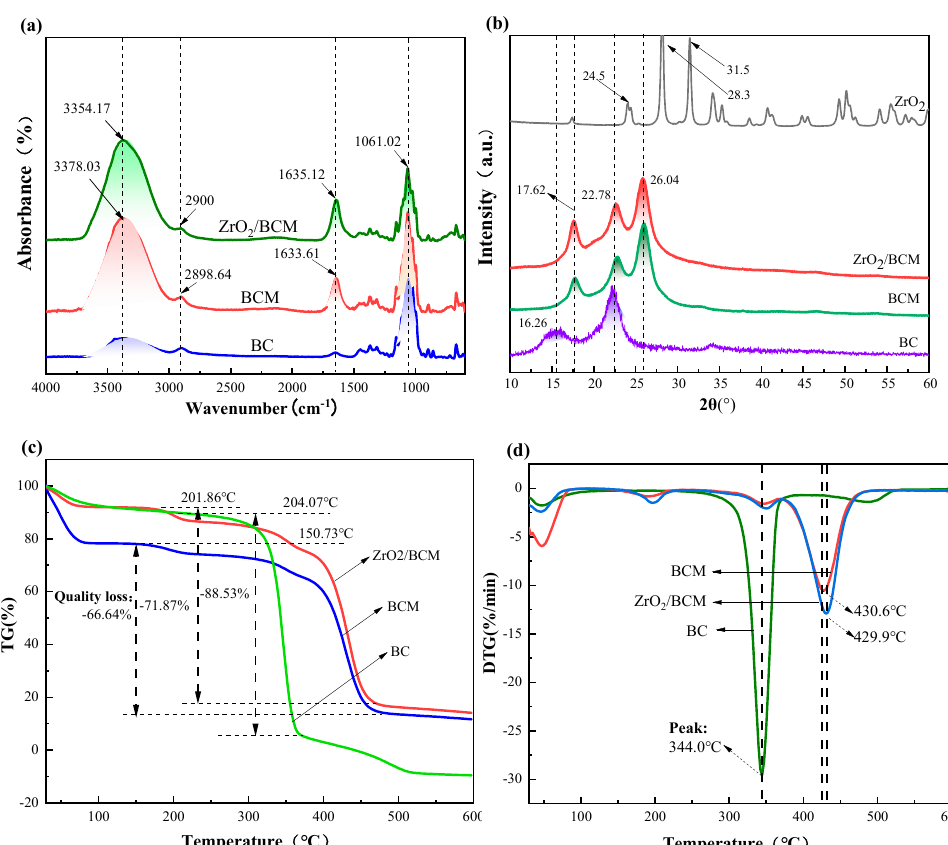
Figure 10. ( a ) FT-IR spectra of regenerated cellulose membrane; ( b ) XRD of BC, BCM, 1 wt.% ZrO 2 /BCM; ( c , d ) TG and DTG patterns for BC, BCM, 1 wt.% ZrO 2 /BCM.